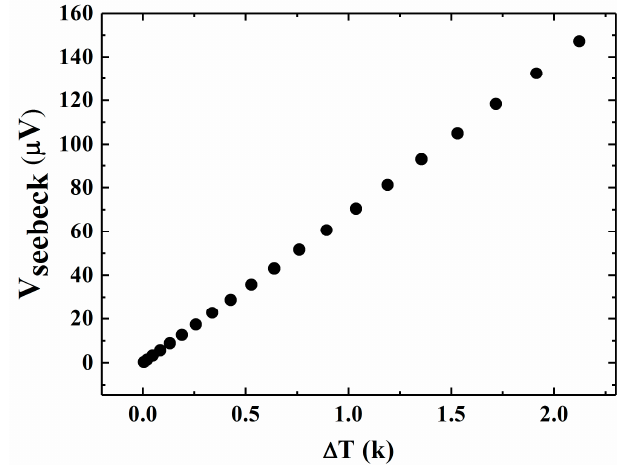
Figure 7. Seebeck voltage as a function of temperature difference.